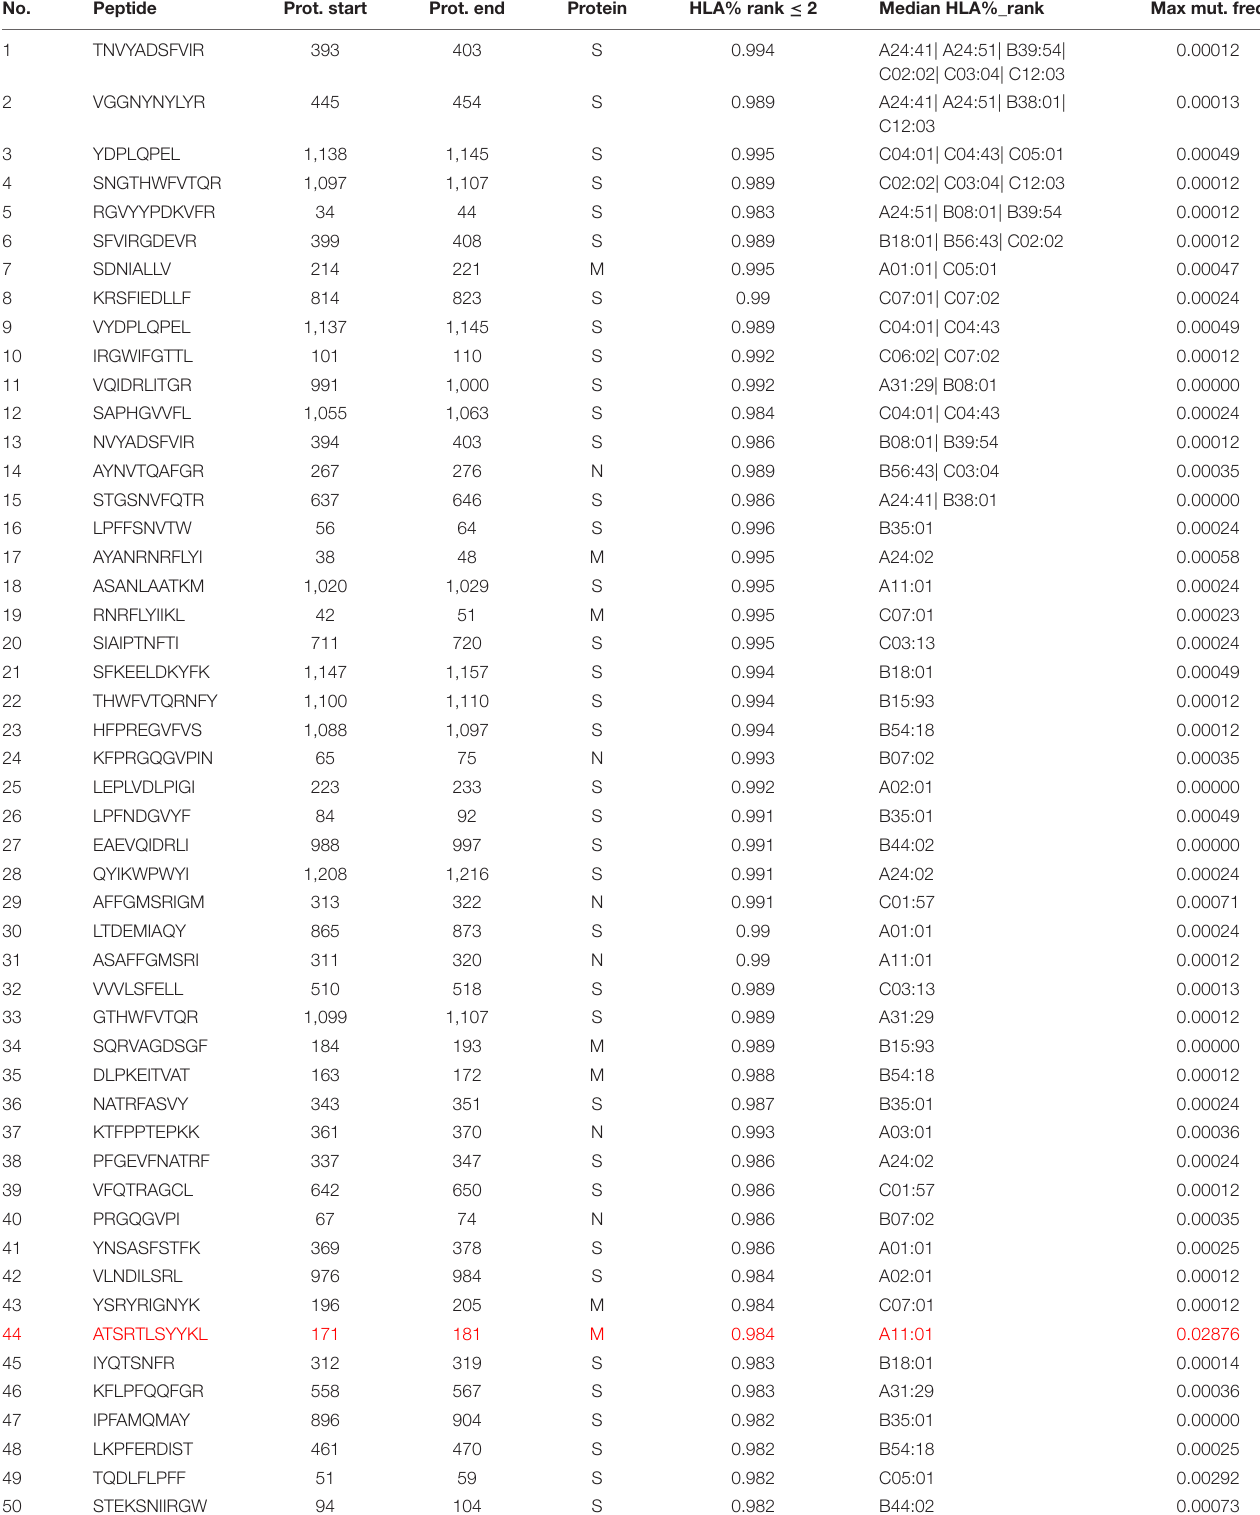
TABLE 3 | Peptides with ArdImmune Rank percentile rank ≤ 2 obtained from SARS-CoV-2 structural proteins, sorted by (1) the number of HLA types capable of binding and presenting given peptide and (2) the median rank across different HLA types. No. Peptide Prot.